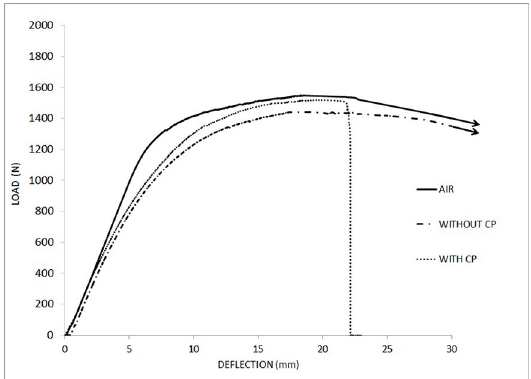
Figure 7. SSRT curves from pearlitic-ferritic steel in three different environments (air; solution with and without